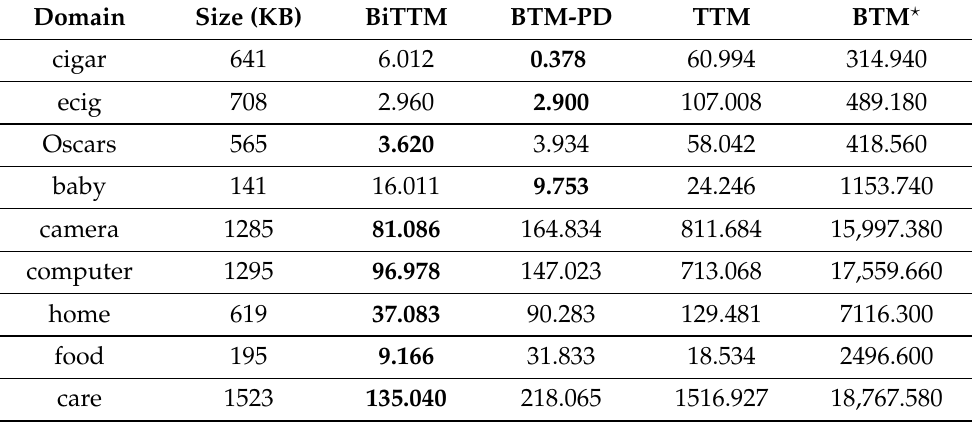
Table 6. The time cost (seconds) of all datasets. The best performance on each dataset is in bold.